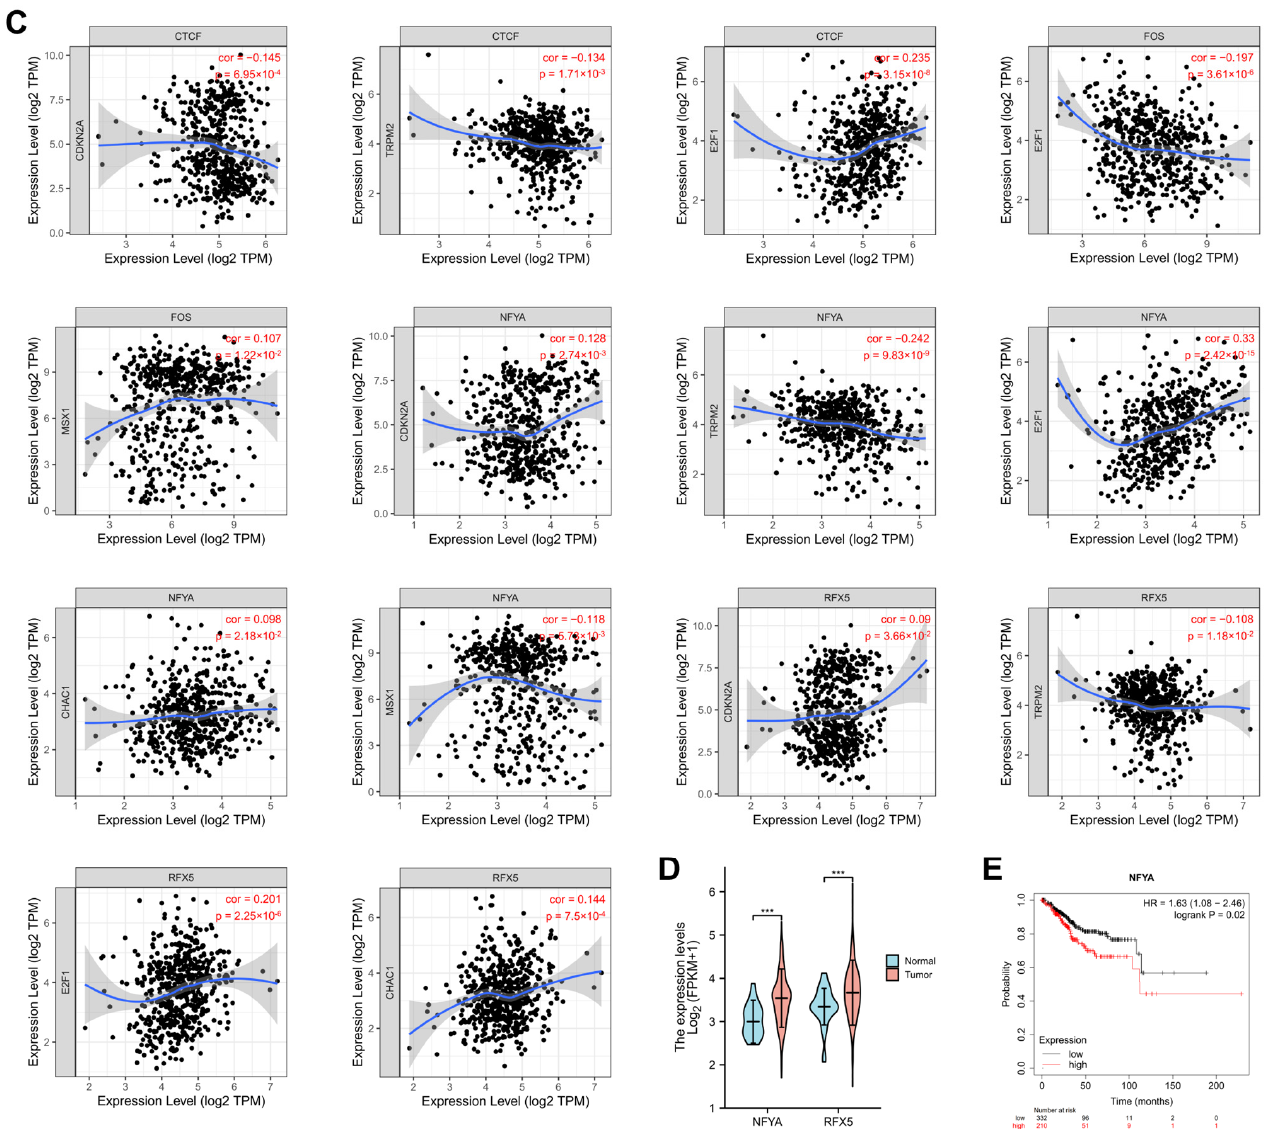
Figure 10. Transcription factors of 7 OSRGs in UCEC: ( A – C ) Top 5 transcription factors showed significant correlations with the 7 OSRGs; ( D ) mRNA levels of NFYA and RFX5 in UCEC tissues and normal tissues; ( E ) Survival analysis of NFYA in UCEC. Note: UCEC: uterine corpus endometrial carcinoma; OSRGs: oxidative stress-related genes. *** represents p < 0.0001